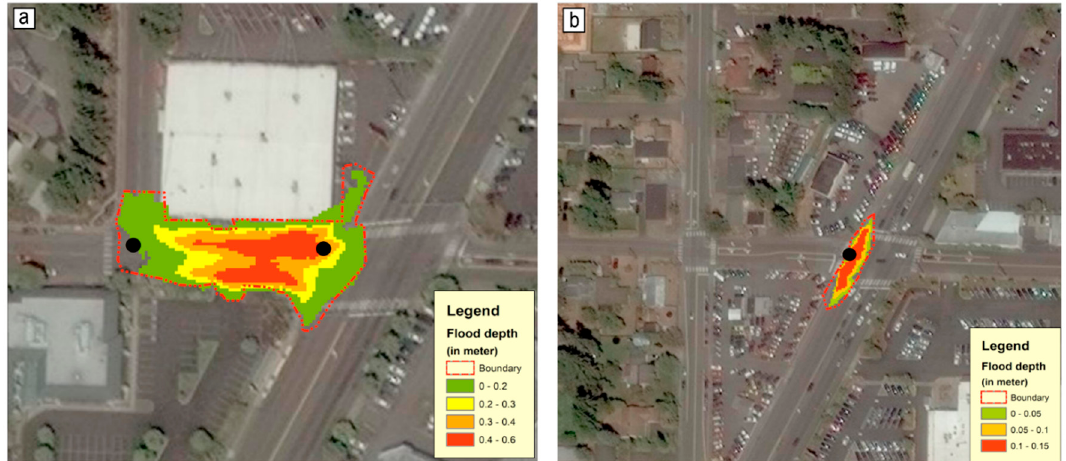
Figure 10. Simulated flood depth and extent (color maps) and observed flood inundation boundaries (red dotted lines). The areal extent and depth of flood in Case 1 ( a ) and Case 2 ( b ).